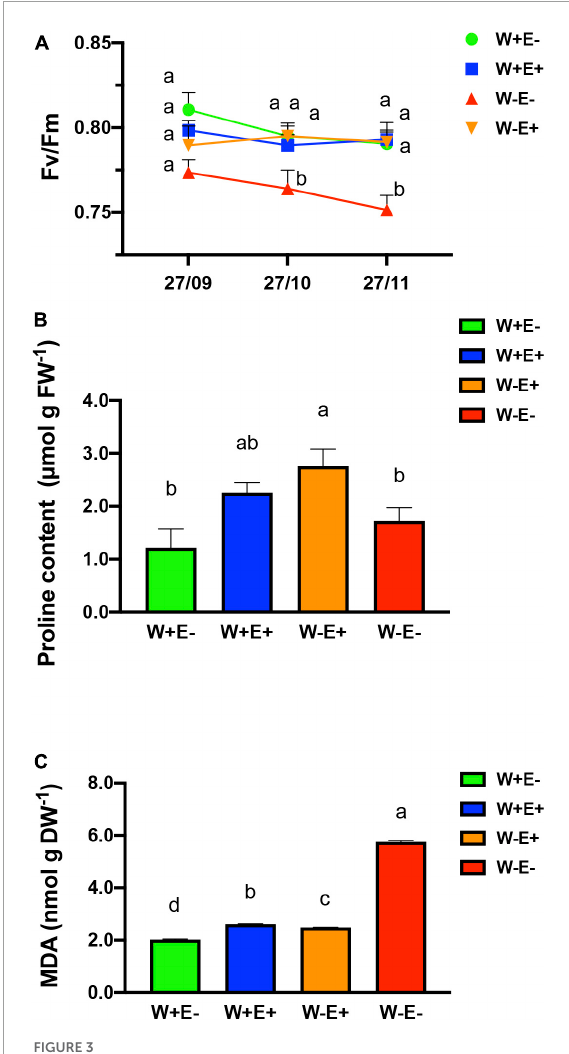
FIGURE3 Physiological and biochemical effects over plant mediated by endophytic fungi. (A) Photosynthetic capacity in strawberry mediated by the presence of endophytic fungi; (B) proline concentration in plants, as a molecular marker of the osmoprotective response; (C) lipid peroxidation analysis. W–E–: without irrigation and without endophyte fungi; W–E+: without irrigation and with endophyte fungi; W+E–: with irrigation (well-watered) and without endophyte fungi; W+E+: with irrigation (well-watered) and with endophyte fungi. Different letters indicate significant differences ( P < 0.05; two-way ANOVA). Bars represent means ± SE from three independent experiments.